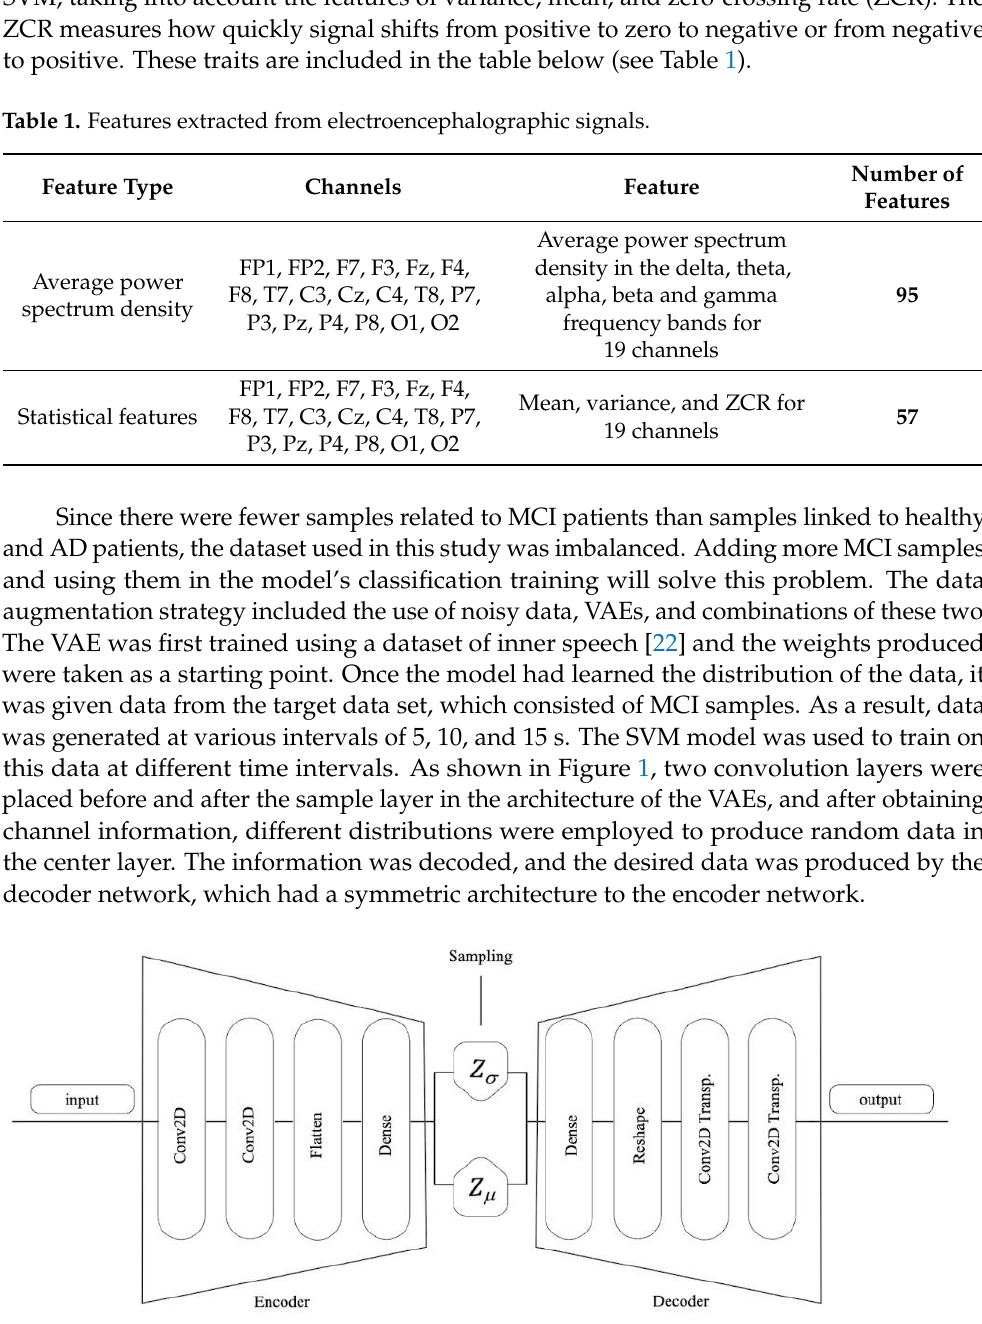
Figure 1. The diagram of the